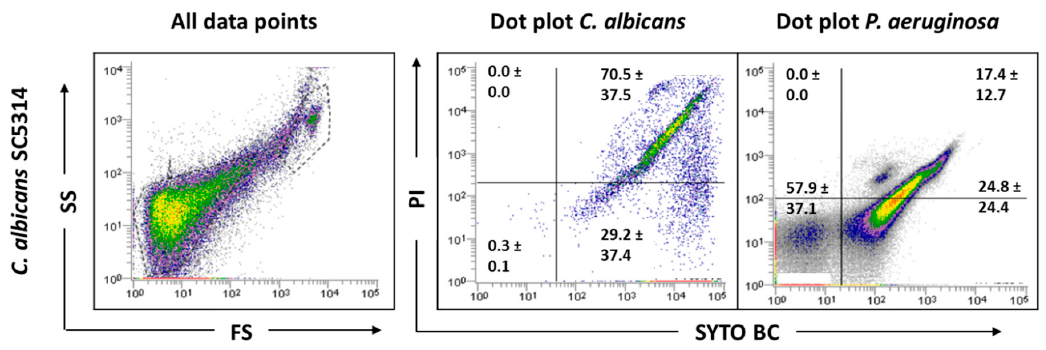
Figure 2. Representative dot plots obtained for C. albicans SC5314 biofilm by FCM. In ‘all data points’, the dot plots SS (Side Scatter) × FS (Forward Scatter) are represented, as acquired in the logarithm. Dot plots of P. aeruginosa and C. albicans represent the areas delineated to represent bacteria and fungi, respectively.